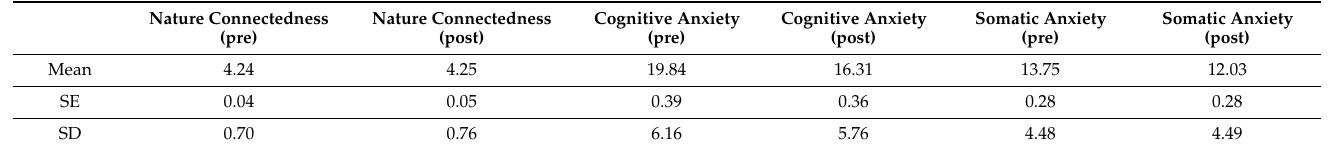
Table 3. Descriptive analysis.